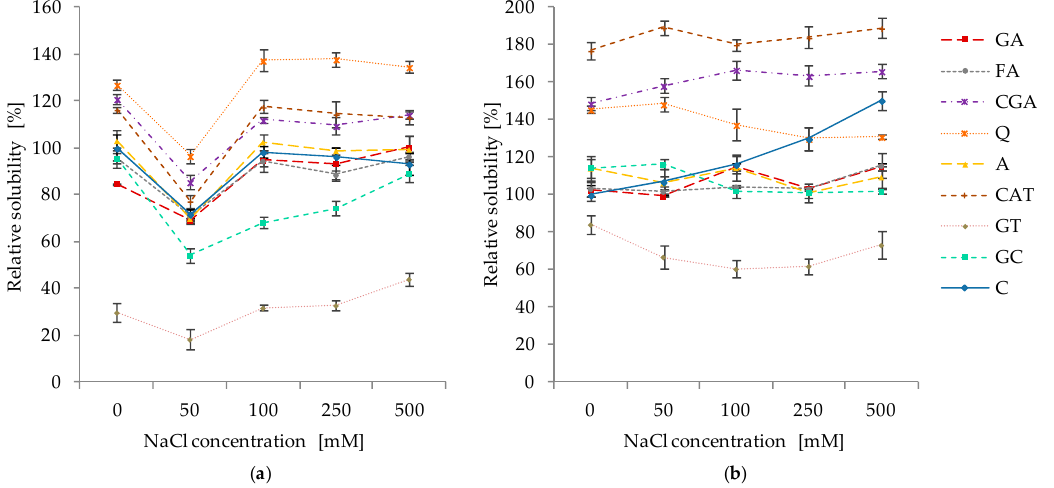
Figure 8. Relative solubility of white bean proteins affected by phenolic compounds at different ionic strengths: ( a ) albumins; and ( b ) globulins. Points represent means ( n = 3) ± SD. C–control sample, GA, FA, CGA, Q, A, CAT, GT, GC–protein samples after incubation with gallic acid, ferulic acid, chlorogenic acid, quercetin, apigenin, catechin, green tea, and green coffee extracts, respectively.